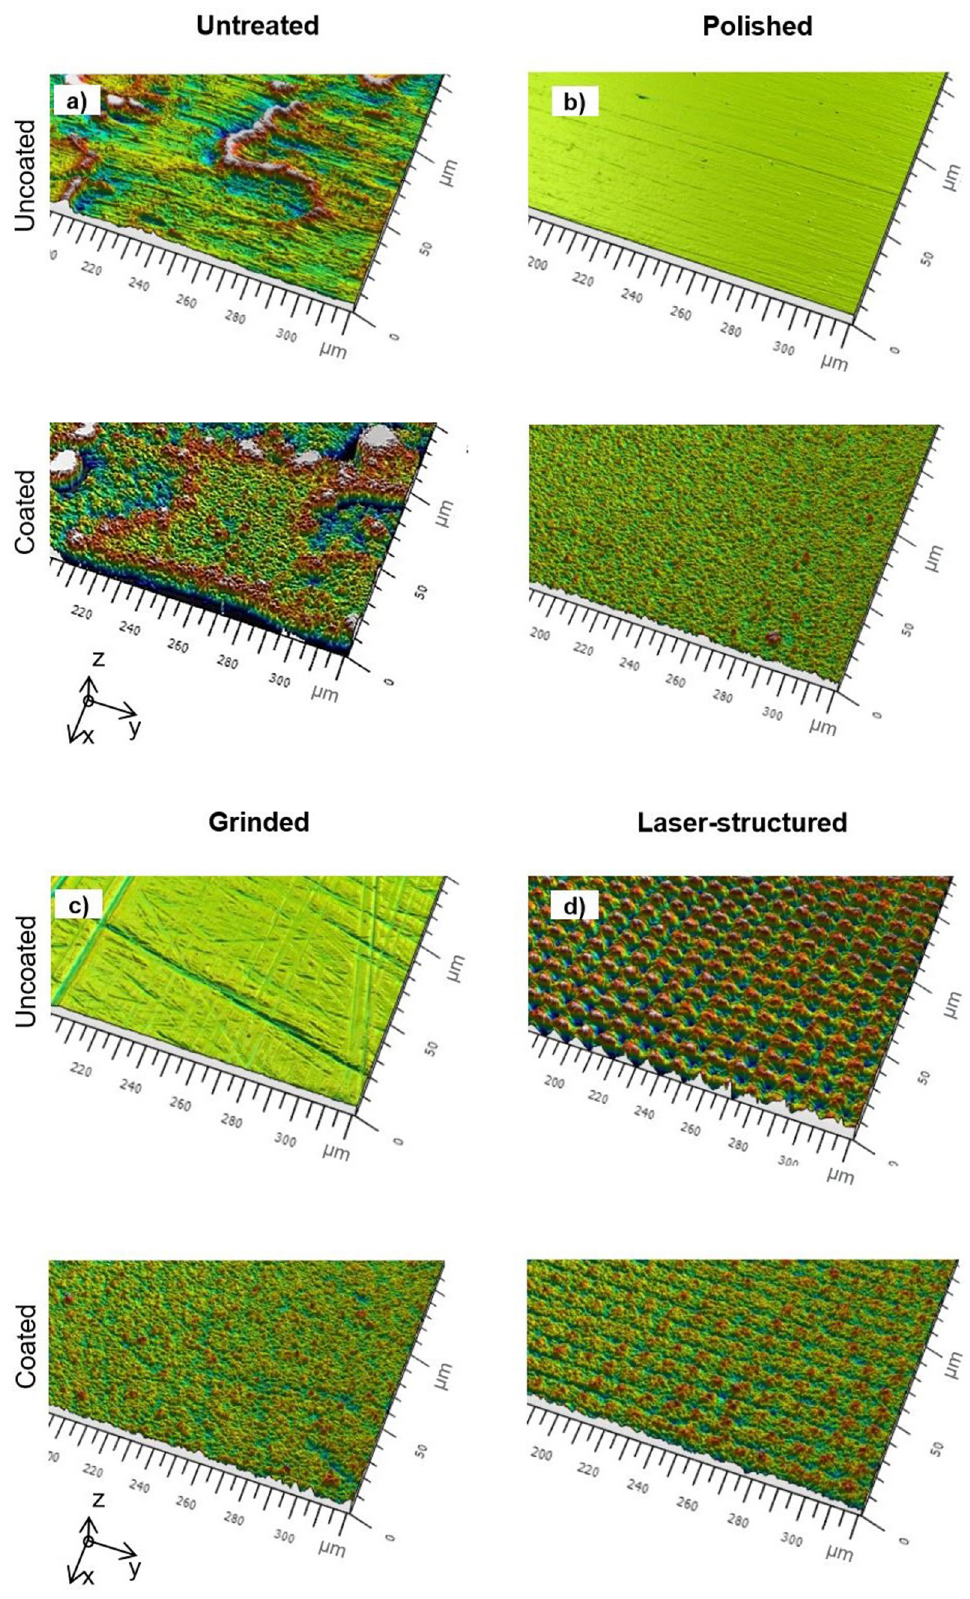
Fig. 3. Surface structures before and after coating, results from confocal